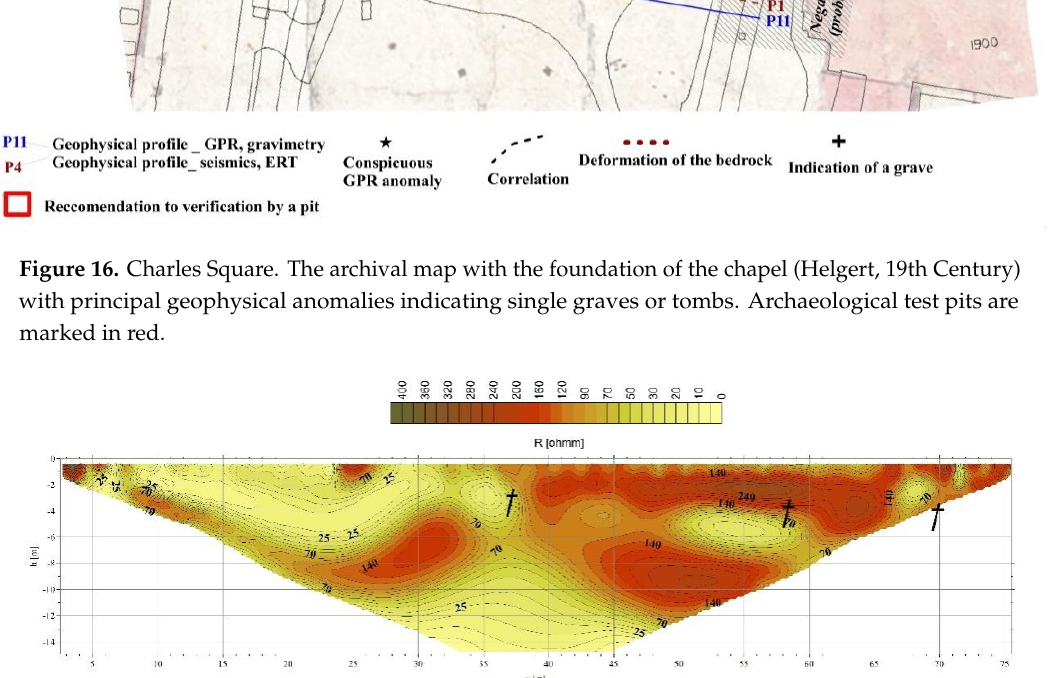
Figure 16. Charles Square. The archival map with the foundation of the chapel (Helgert, 19th Century) with principal geophysical anomalies indicating single graves or tombs. Archaeological test pits are marked in red.